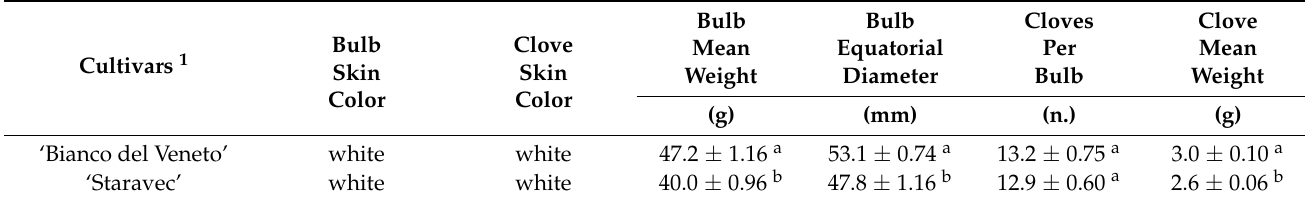
Table 5. Morphological traits of bulbs and cloves of A. sativum cultivars.